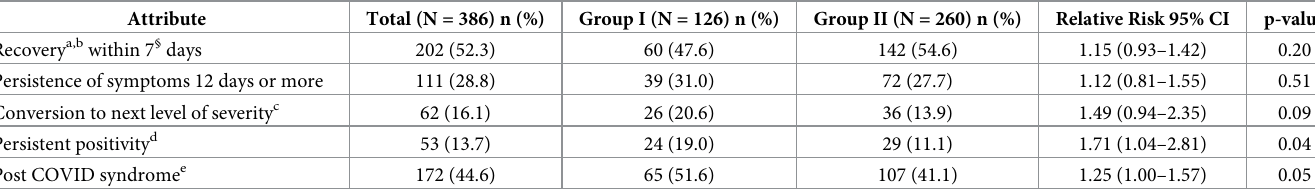
Table 3. Outcome of COVID-19 patients among Group I and Group